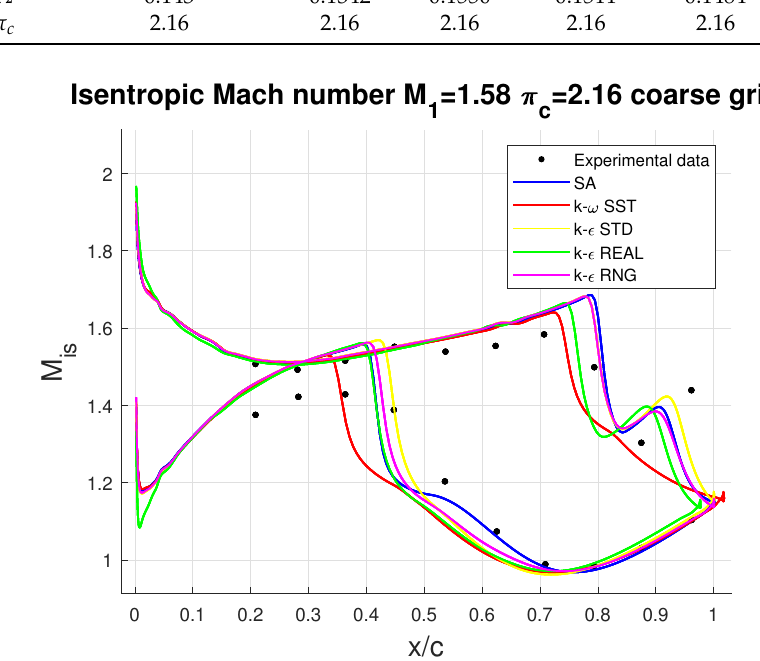
Figure 3. Isentropic Mach number: experimental data and numerical calculations with different turbulence